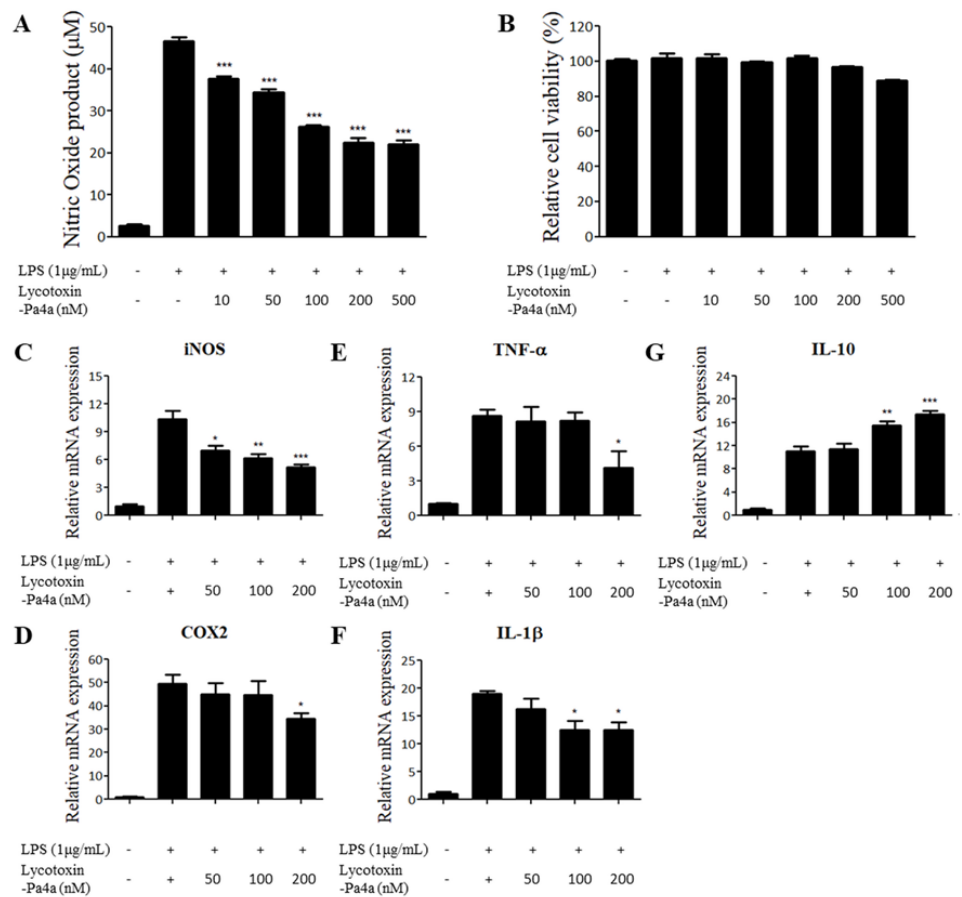
Figure 4. Effect of Lycotoxin-Pa4a on LPS-stimulated macrophage RAW 264.7. ( A ) Treatment of Lycotoxin-Pa4a dose-dependently decreased the production of NO up to a concentration of 500 nM. ( B ) Up to a concentration of 200 nM, cell viability remained at >90% compared with that associated with the control. ( C – F ) mRNA transcripts of the pro-inflammatory mediators, iNOS, COX2, TNF- α , and IL-1 β, were suppressed by peptide treatment. ( G ) Anti-inflammatory mediator IL-10 was upregulated upon cotreatment with LPS and Lycotoxin-Pa4a.* p < 0.05, ** p < 0.01, and *** p < 0.001 indicated a significant difference compared with the LPS control.